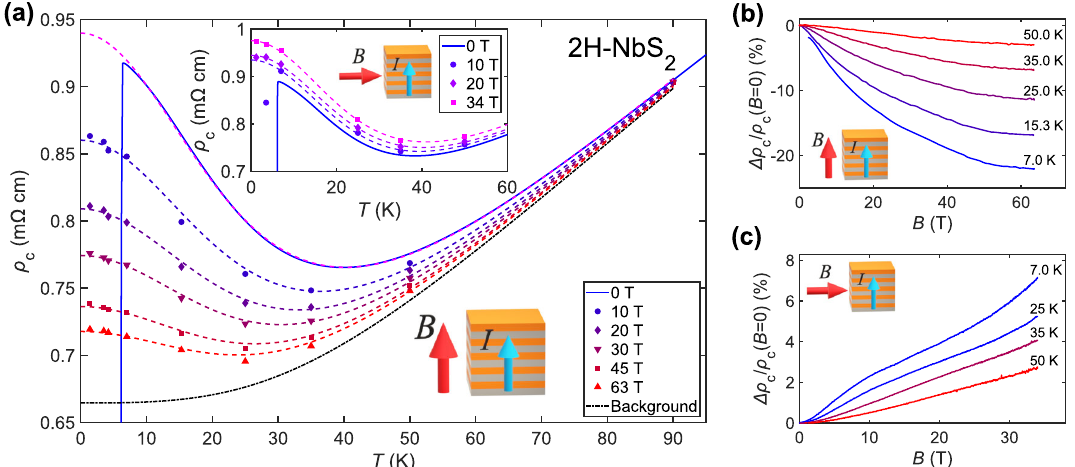
Fig. 3 Out-of-plane magnetotransport in 2H-NbS 2 . a Out-of-plane resistivity ( ρ c ) as a function of temperature ( T ) for various longitudinal (main plot) and transverse (inset) magnetic fi elds ( B ). Solid lines and markers represent the measured data. Dashed lines in the main plot are fi ts according to the numerical renormalisation group theory of Kondo effect. The fi tted model includes a fi eld-independent contribution due to the residual temperature-independent resistance as well as the electron – phonon scattering, described by the Bloch-Grüneisen formula (dash-dot line). Dashed lines in the inset are guides for the eye. The two datasets were collected using different samples, which explains the slight resistivity mismatch for zero fi eld. b , c Relative changes in ρ c , under out-of-plane ( b ) and in-plane ( c ) magnetic fi